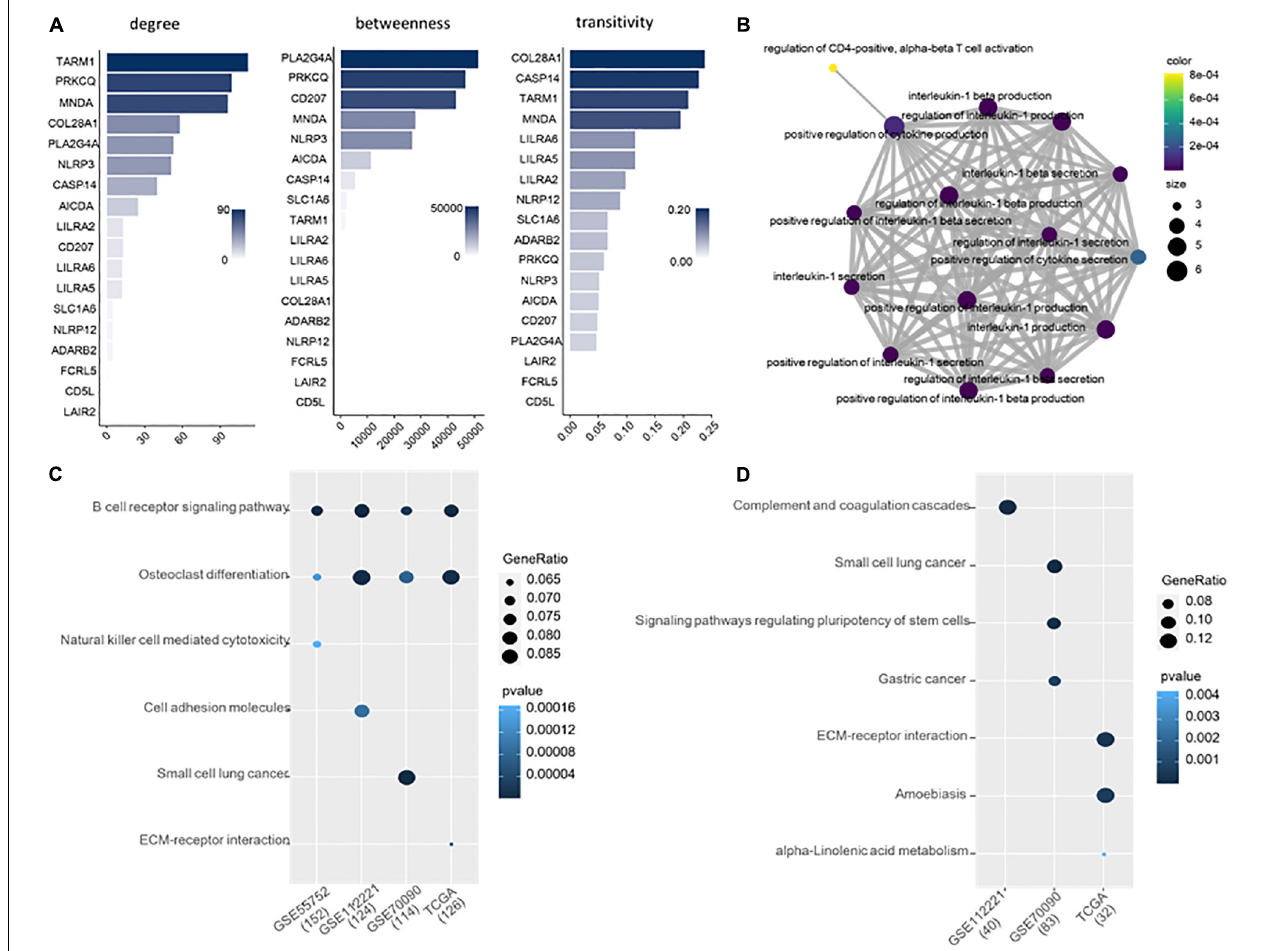
FIGURE 3 | (A) Ranking of the 18 DMGs by topological importance. (B) Enrichment analysis of the 18 genes. (C) Enriched KEGG pathways for the DMGs of each of the four datasets. (D) Enriched KEGG pathways for the DMGs exclusive in each